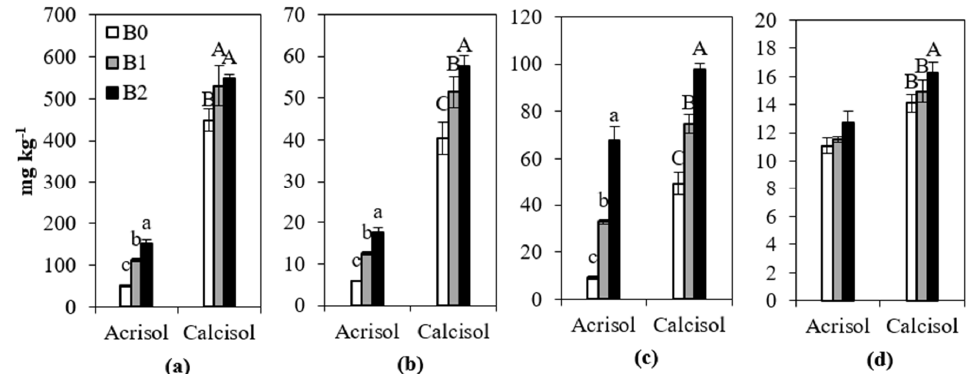
Figure 1. Cumulative leaching losses of Calcium ( a ), Magnesium ( b ), Potassium ( c ) and sodium ( d ) from Acrisol and Calcisol. B0, control without biochar addition; B1 and B2, 1% and 2% biochar addition, respectively. Bars indicate standard error of the mean (n = 4). Different letters indicate significant differences at p < 0.05.